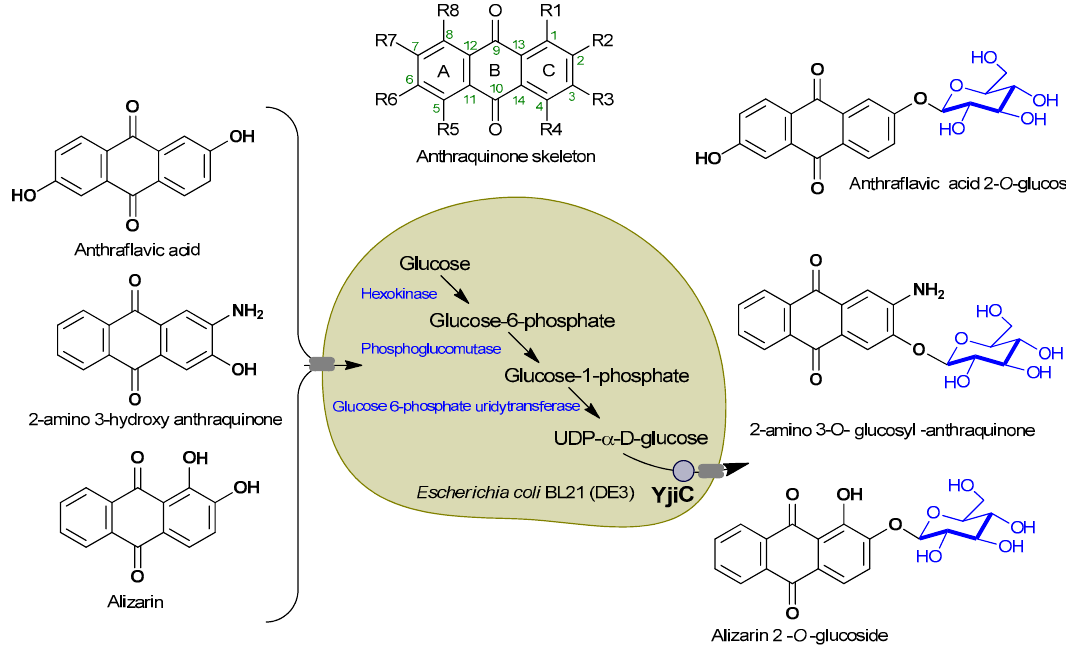
Figure 1. Scheme showing pathway and utilizing Escherichia coli indigenous UDP-glucose by Bacillus glycosyltransferase for modification of selected anthraquinones into respective glucosides.